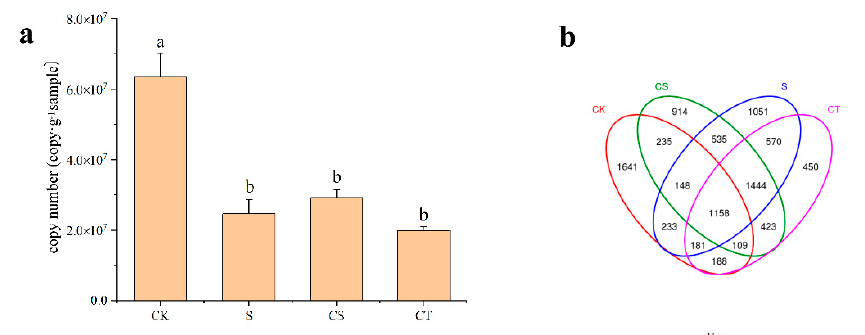
Figure 1. ( a ) Abundance of microbial phoD gene (copy number) quantified by QPCR. ( b ) Unique and shared OTUs among the different treatments by Venn analysis. Different lowercase letters indicate a significant difference between treatments ( p < 0.05).